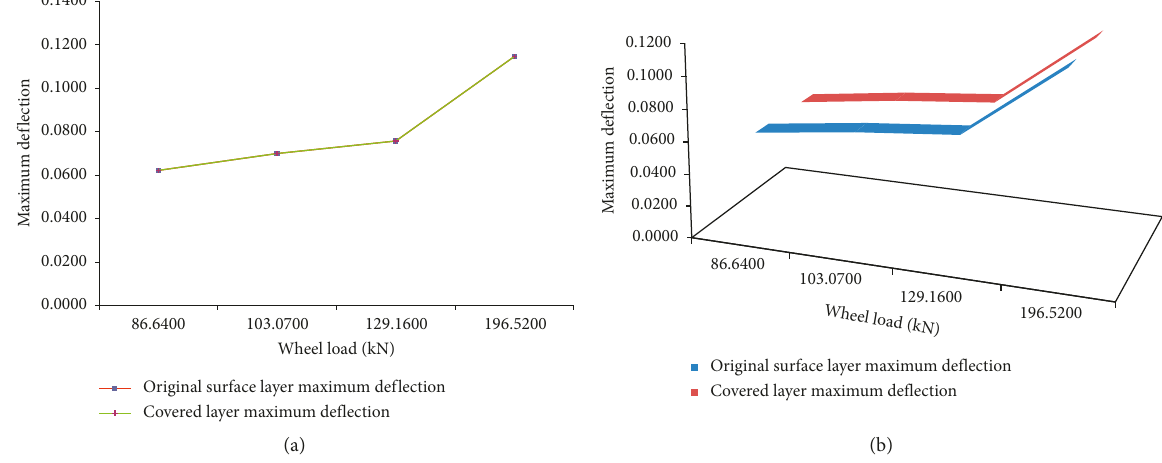
Figure 15: Variation of maximum deflection with wheel load: (a) two-dimensional broken-line graph; (b) three-dimensional broken-line